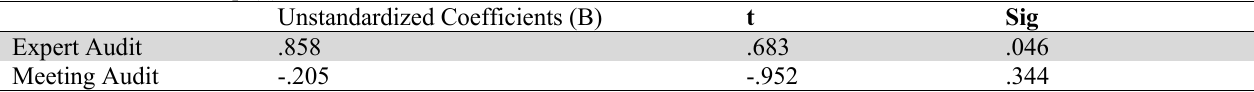
Statistical Results of Eq.